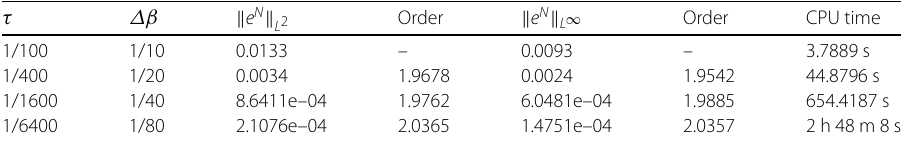
Table 2 Errors and convergence orders of scheme (43)–(44) with h 1 = h 2 = π size ratio for τ and Δβ (Example 1)